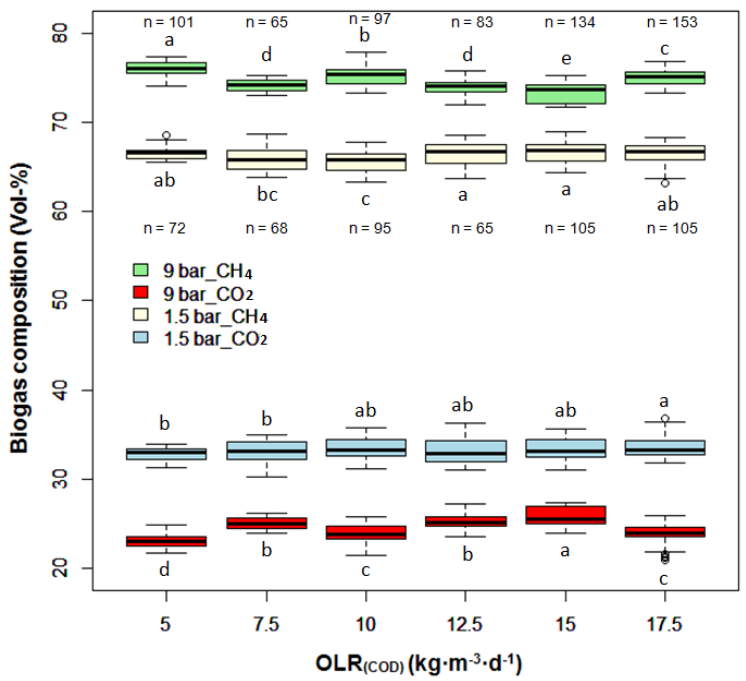
Figure 4. Biogas composition at different OLR and pressure levels. The box plot is characterized with the minimum, low quartile, median, upper quartile and maximum value. Significant differences among the OLR levels are marked with different letters ( p < 0.05, LSD